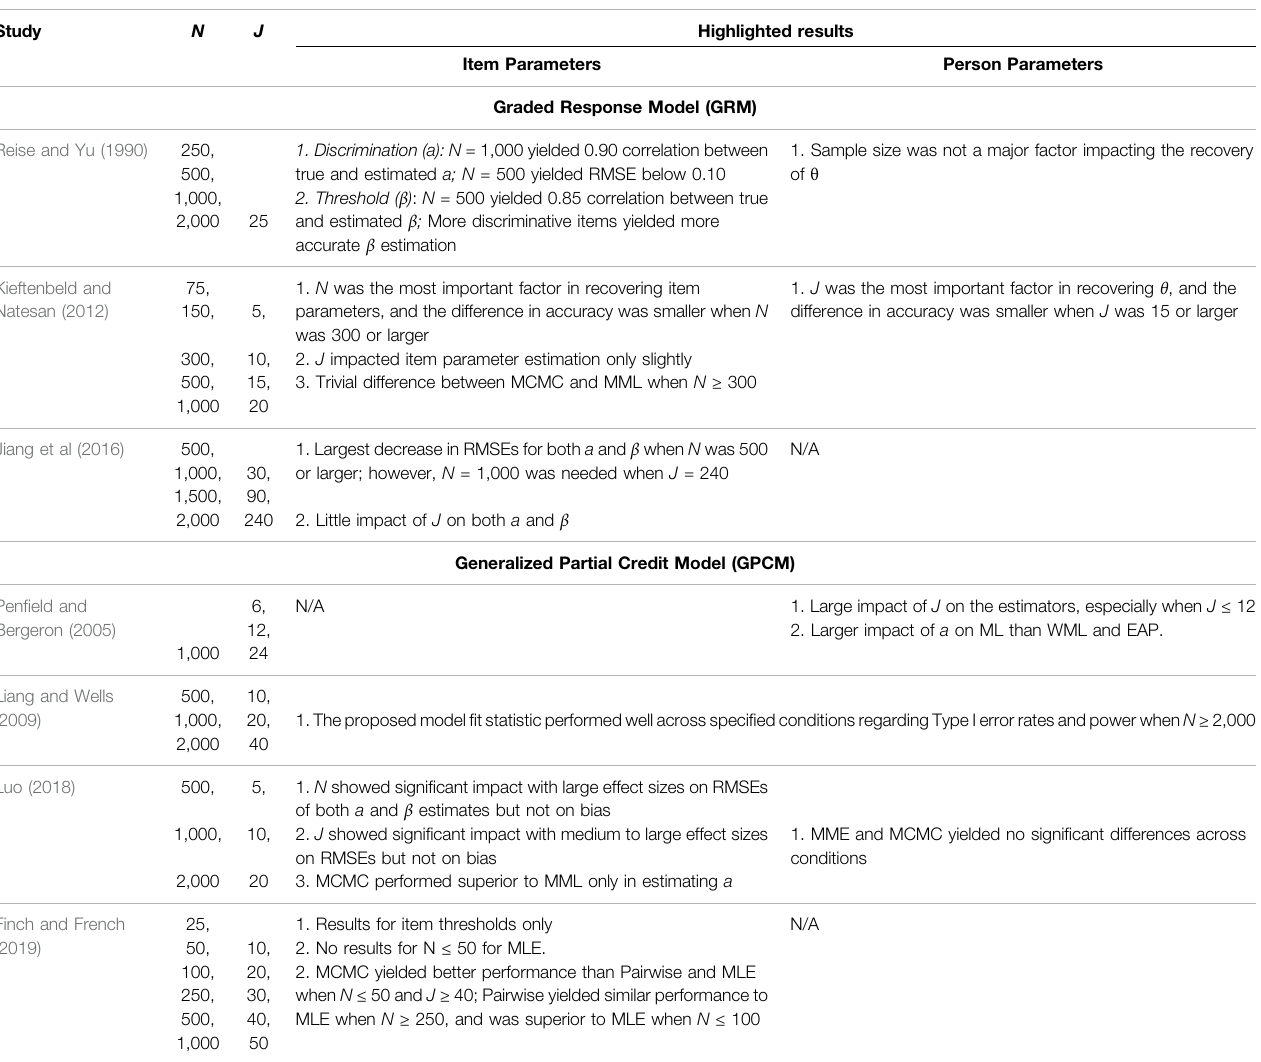
TABLE 2 | Highlighted Results of Previous Literature on the Performance of GRM and GPCM Regarding Sample Size and Instrument Length.